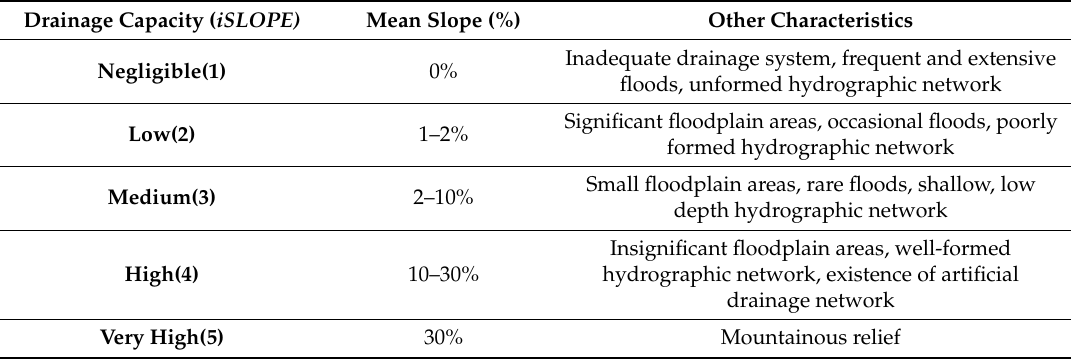
Table 5. Drainage capacity (iSLOPE) classes based on mean slope and associated soil